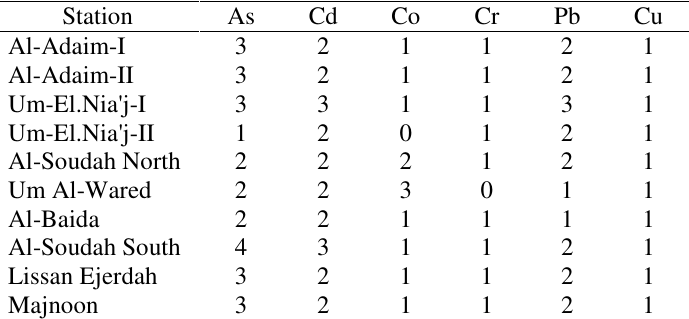
Table 3. The results of Geochemical Index